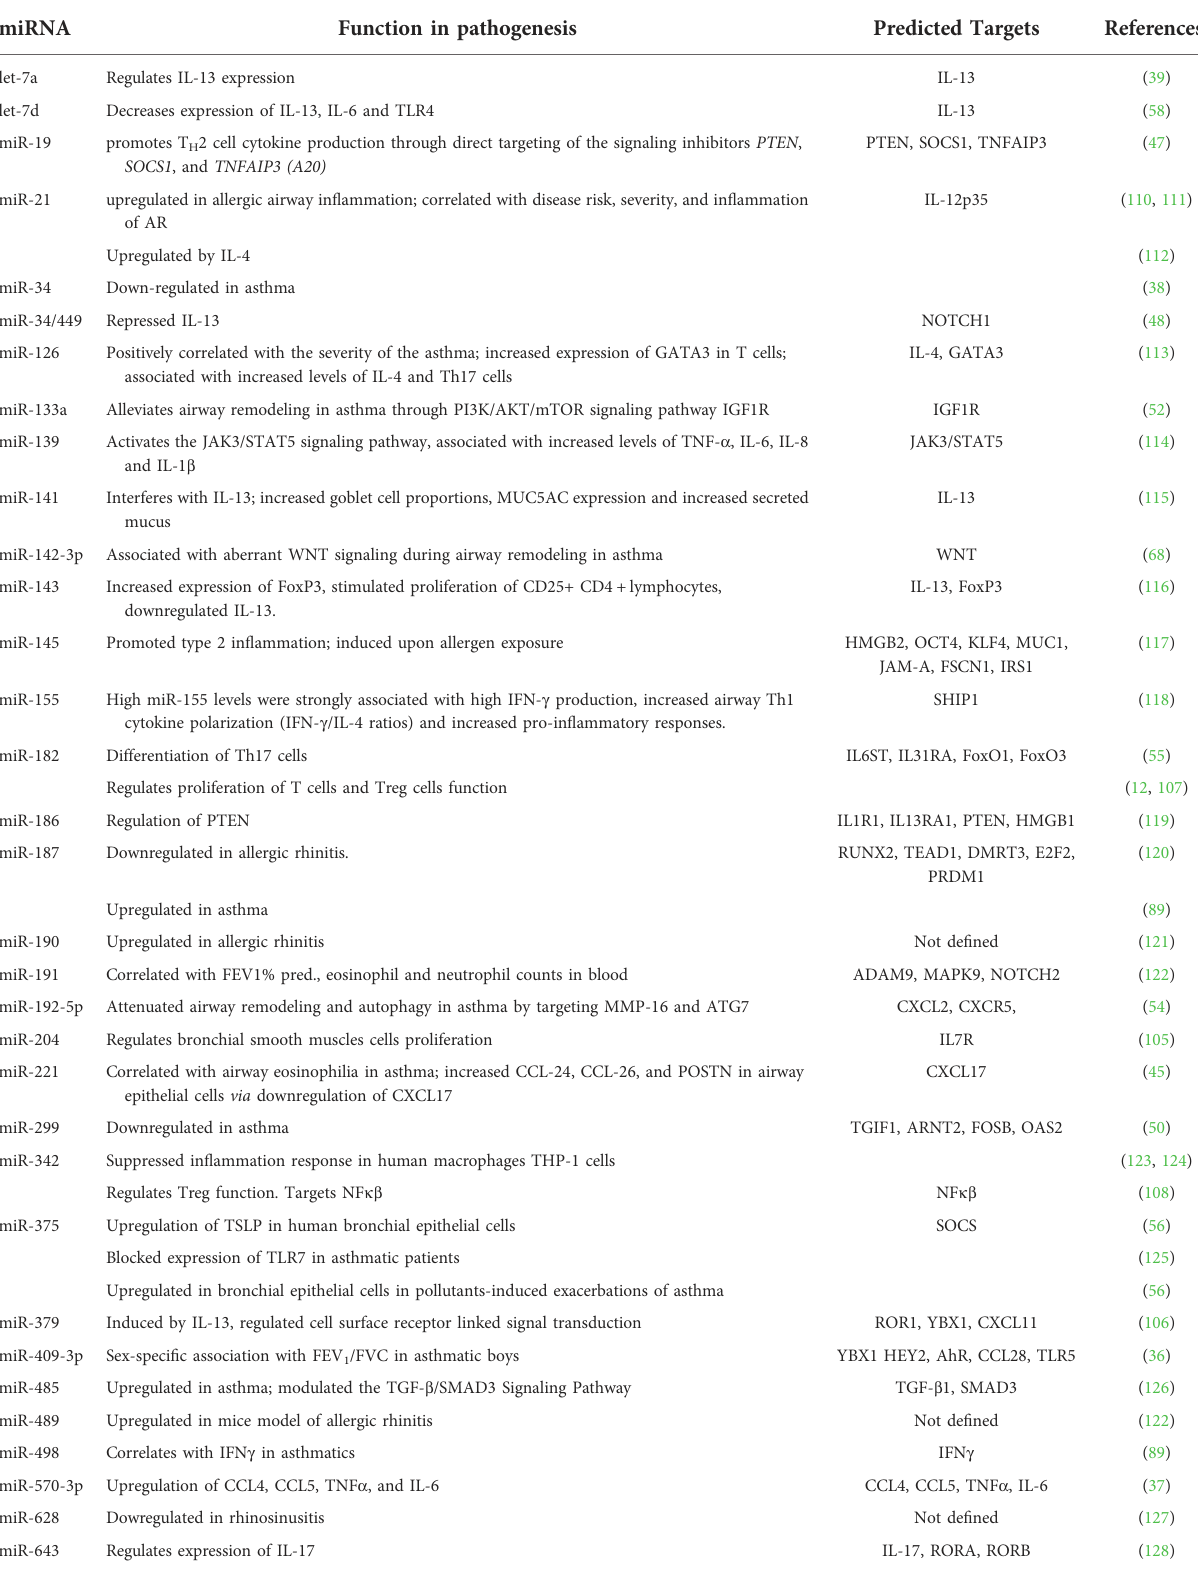
TABLE 1 Micro-RNAs in type 2-driven diseases.